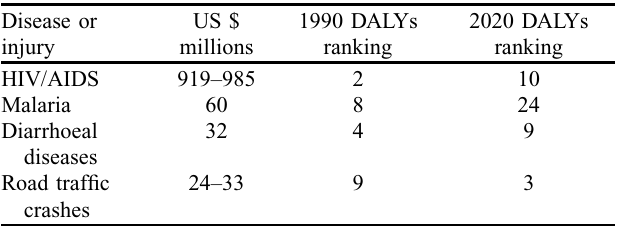
Table 1. Estimated global research and development funding for selected topics [3].